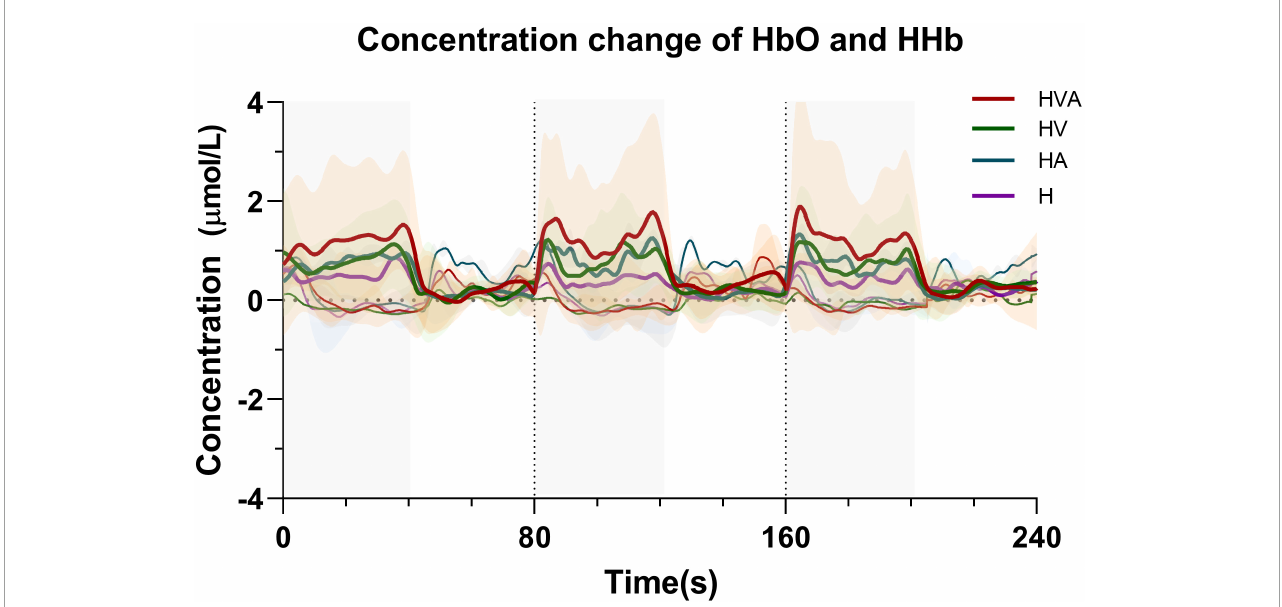
FIGURE5 Time series of oxyhemoglobin (HbO) and HHb changes during the task. The solid line represents the mean of the concentration and the shade represents the error (mean ± SD) ( n = 20). The three areas separated by dotted lines in the figure represent three trials, where the first 40 s of each trial are the task phase. The red, green, blue, and purple curves represent HVA, HV, HA, and H modes, respectively. Thicker lines represent HbO and thinner lines represent HHb. The abbreviations in the figure represent haptic (H), haptic + auditory (HA), haptic + visual (HV), and haptic + visual + auditory